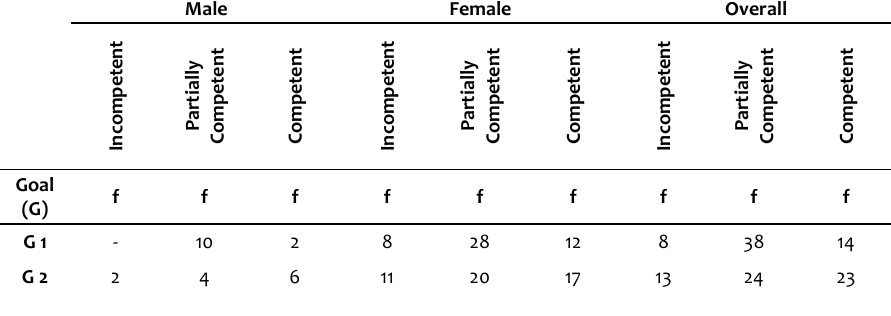
Table 2. The pre-service teachers’ views of their competence in associating the learning outcomes in the science curriculum with SDG Male Female